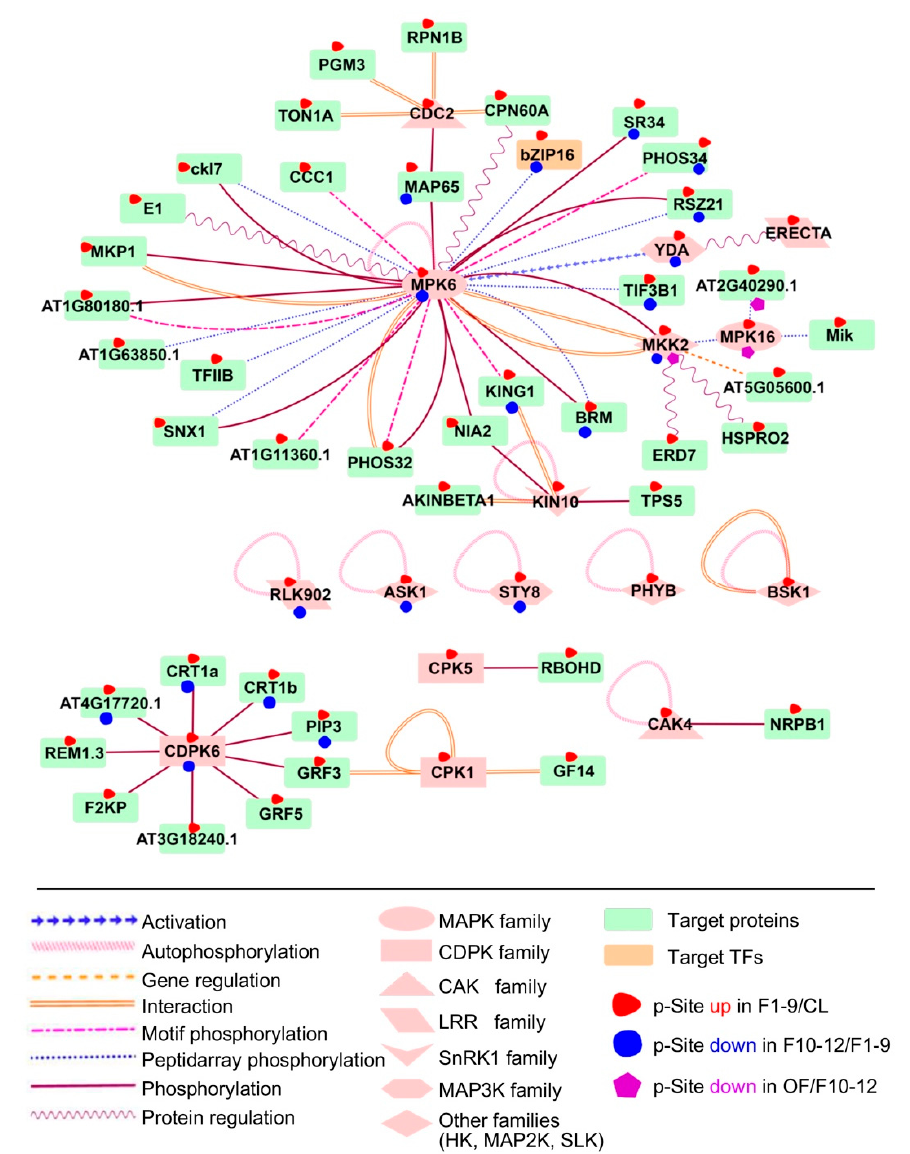
Figure 9. Substrates of MAPK6 and CDPK6 were highly enriched in both F1–9/CL and F10–12/F1–9 comparisons. Significant phosphorylation changement of each protein in each comparison pairs are highlighted with different coloured-shapes as indicated in legends under the illustration.